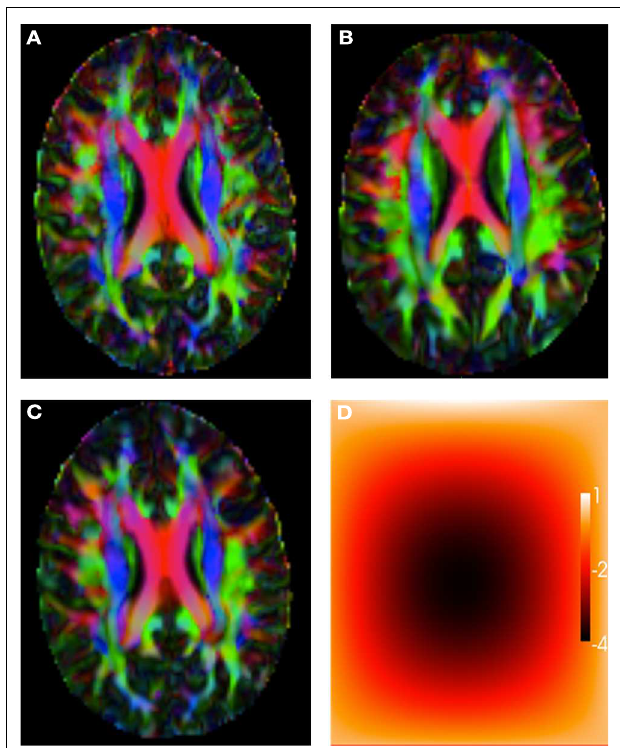
FIGURE 1 | (A) Reference image. (B) Affinely warped reference image. (C) Non-linearly warped reference image using a small displacement field, (D) Non-linear small deformation